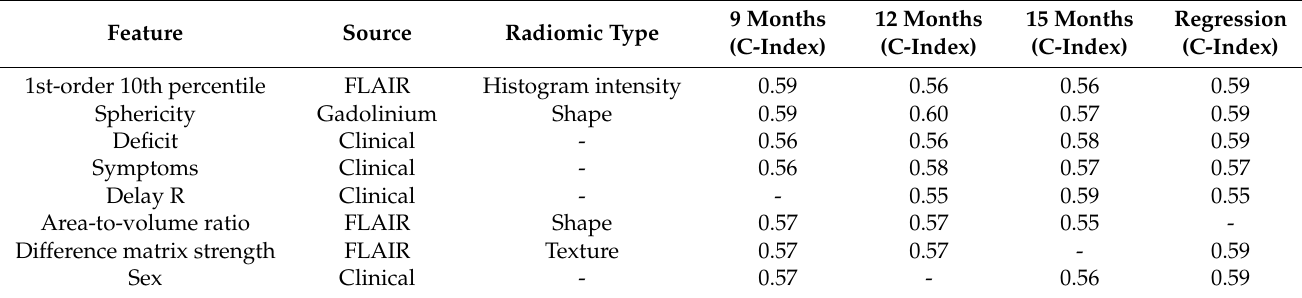
Table 6. Essential features based on their C-index with the OS on the training set